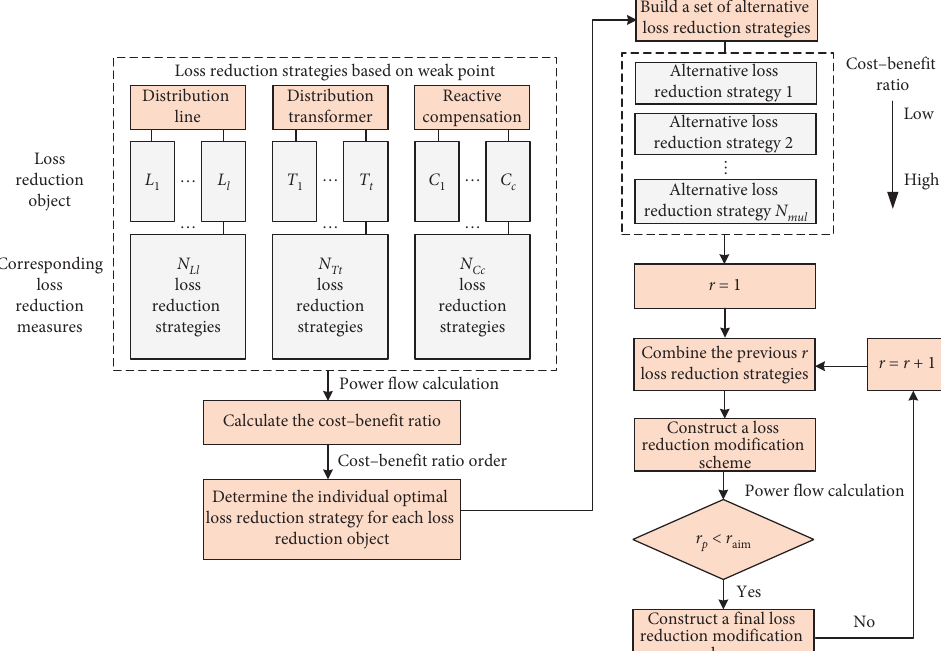
Figure 3: The solution process of the combined loss reduction strategy optimization model based on the cost-benefit